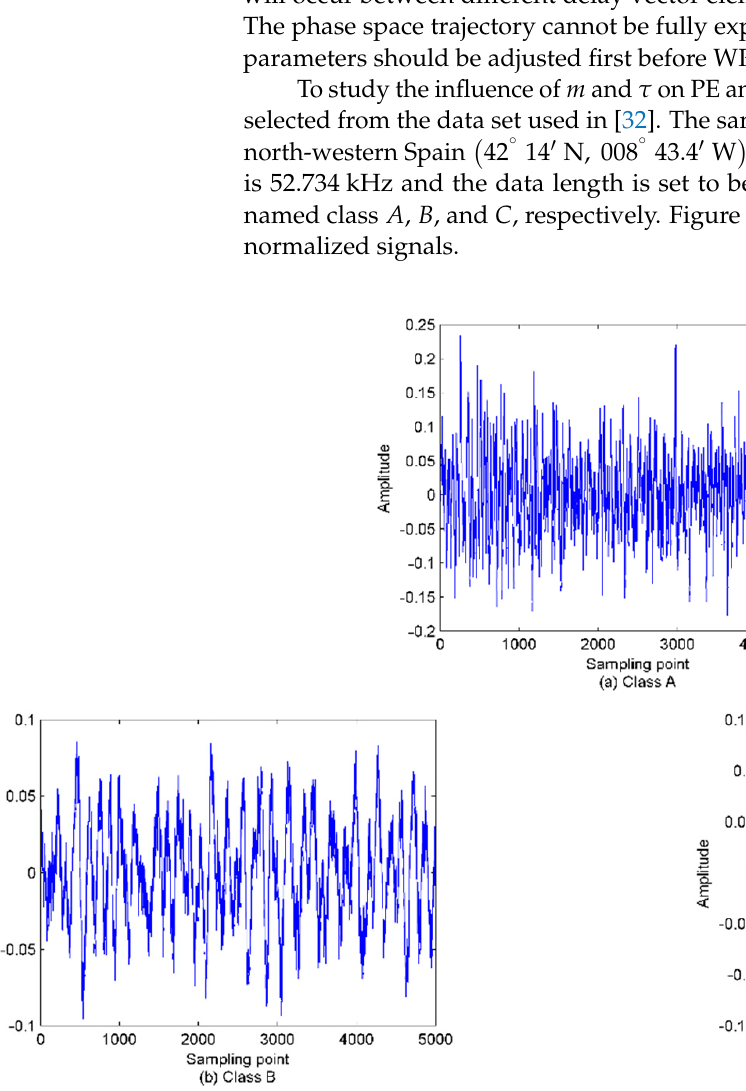
Figure 9. The time-domain waveforms for the three types of normalized ship − radiated noise (SRN). ( a ) Class A signal; ( b ) Class B signal; ( c ) Class C signal. As in [30], the PE and WPE of the three types of SRN signals are calculated under the condition m = 3, 4, 5, 6, 7, and the time delay ranges from 1 to 20. The results are shown in Figure 10. As seen in Figure 10, the class C SRN signal has the maximum entropy value and thus the highest